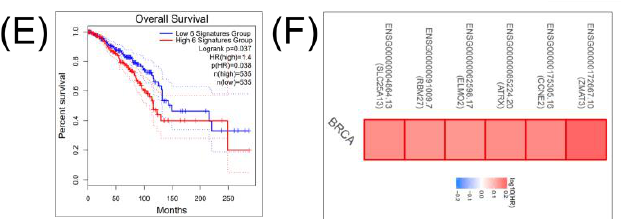
Figure 5. A common CSC and EMT overexpressed miRNA expression signature in BRCA. ( A ) A Venn diagram of the downregulated miRNAs of CSCs and EMT in BRCA (downloaded from NCBI), as well as a common signature among these CSC and EMT transcript lists; bold-lettered genes predict the overall survival. ( B ) Those miRNAs capable of predicting the overall survival (miR-21, miR-96, miR-142, miR-200a, and miR-200c). ( C ) An interaction network using miRTargetLink software (strong interaction) for miRNAs involved in CSCs and EMT and correlated with the overall survival. ( D ) Overall survival analysis of genes targeted by miRNA and correlated with the survival rate (SLC25A13, RBM27, ELMO2, ATRX, CCNE2, and ZMAT3). ( E ) Overall survival rate of a six-gene signature (SLC25A13, RBM27, ELMO2, ATRX, CCNE2, and ZMAT3). ( F ) A survival map of the selected six-gene